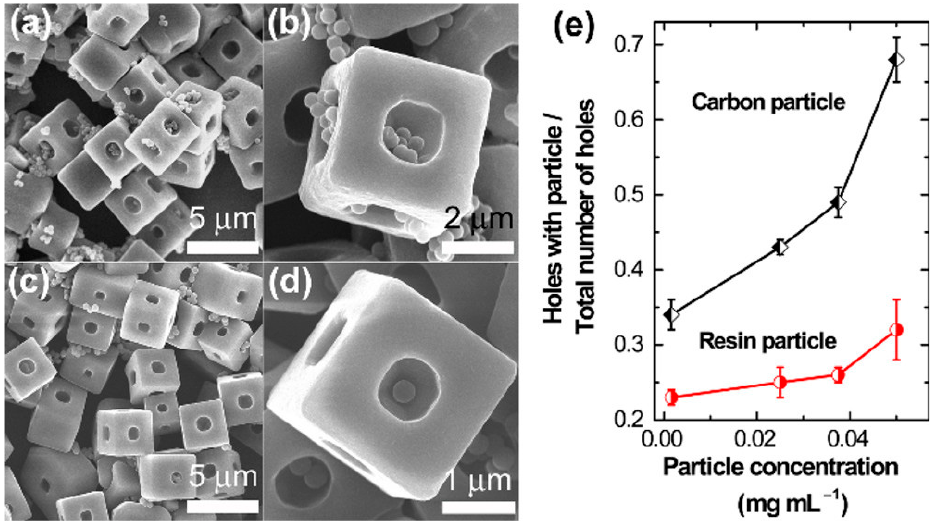
Figure 8. ( a – d ) SEM images showing different loading capacities of the OH-cubes toward carbon and polymer particles (0.05 mg/mL). ( e ) Plots of number of holes containing particle(s)/total number of holes vs. particle concentration. Reproduced from [121] with permission from the American Chemical Society, copyright 2017.